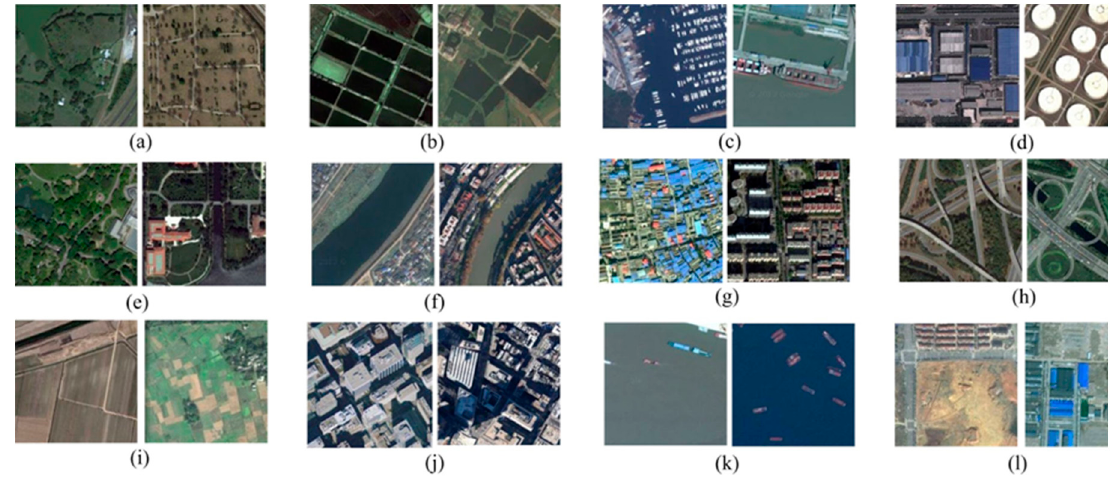
Figure 8. Class representatives of the Google dataset of SIRI-WHU: ( a ) meadow, ( b ) pond, ( c ) harbor, ( d ) industrial, ( e ) park, ( f ) river, ( g ) residential, ( h ) overpass, ( i ) agriculture, ( j ) commercial, ( k ) water, and ( l ) idle land.